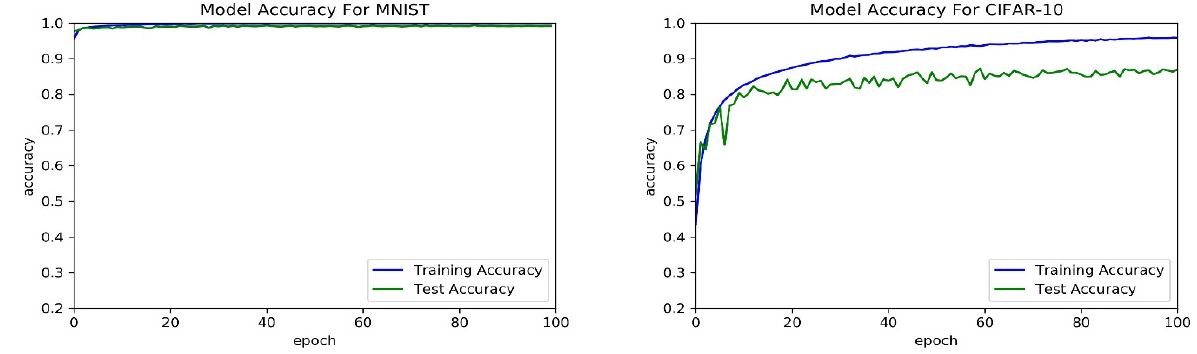
Fig. 5: Accuracy of MNIST AND CIFAR-10 Data Sets